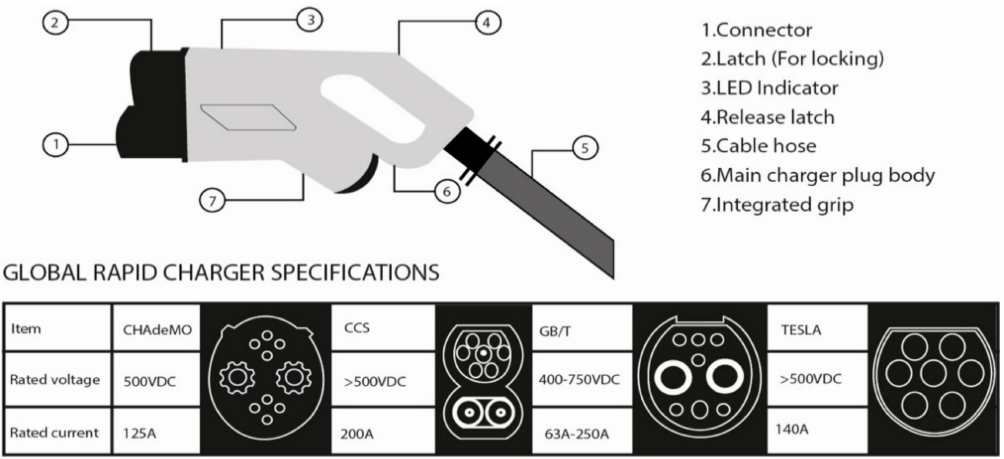
Figure 1. Global DC rapid charger connector configurations.